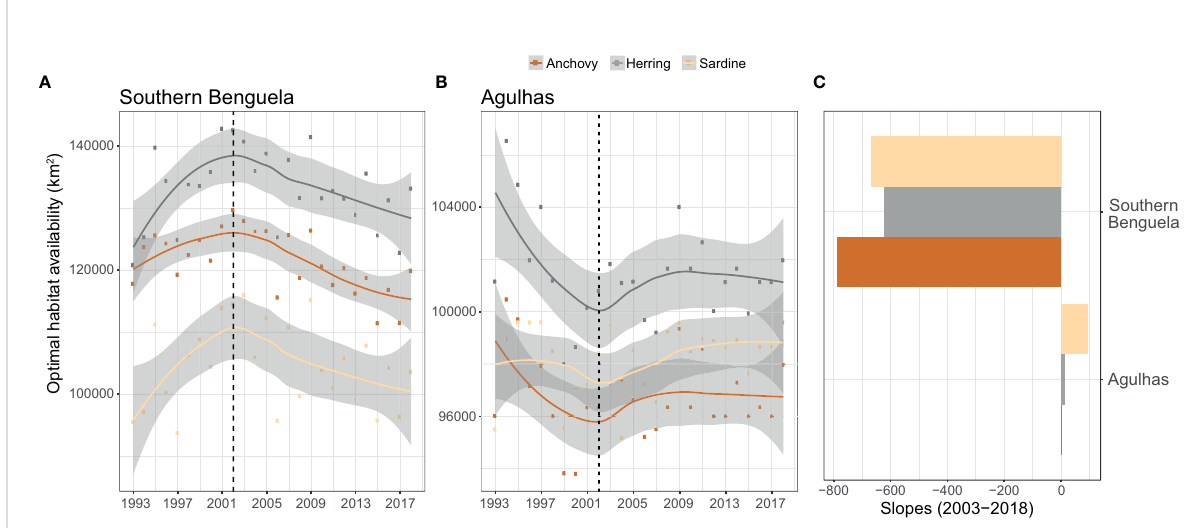
FIGURE 3 (A, B) Long term (1993-2018) trends in the extent (km 2 ) of marine areas encompassing optimal ranges of depth, SST, SSS and NPP (i.e., optimal habitat availability) for three small pelagic fi sh species in (A) the Southern Benguela (west coast) and (B) Agulhas (south coast) systems. A regime shift was observed in 2002. Bar plots in (C) represent the slopes (magnitude) for the linear regressions on the long-term trends in the absolute values of optimal habitat availabilities for the post-in fl ection period